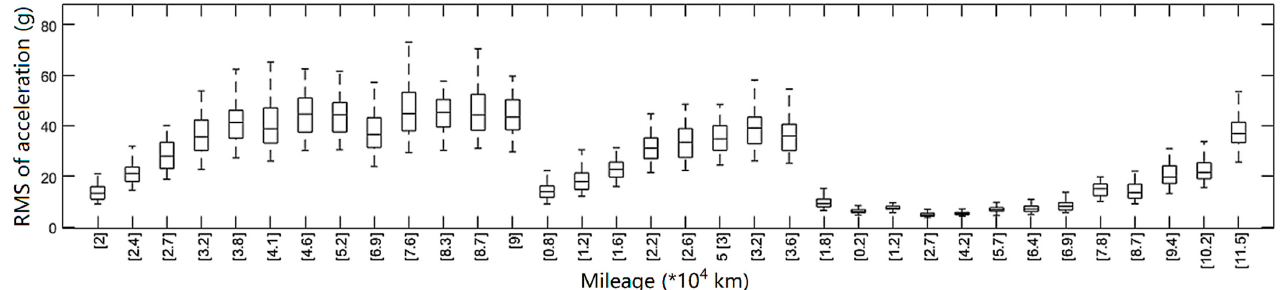
Figure 2. The evolution trend of vibration acceleration of high-speed train gearboxes with operating mileage.